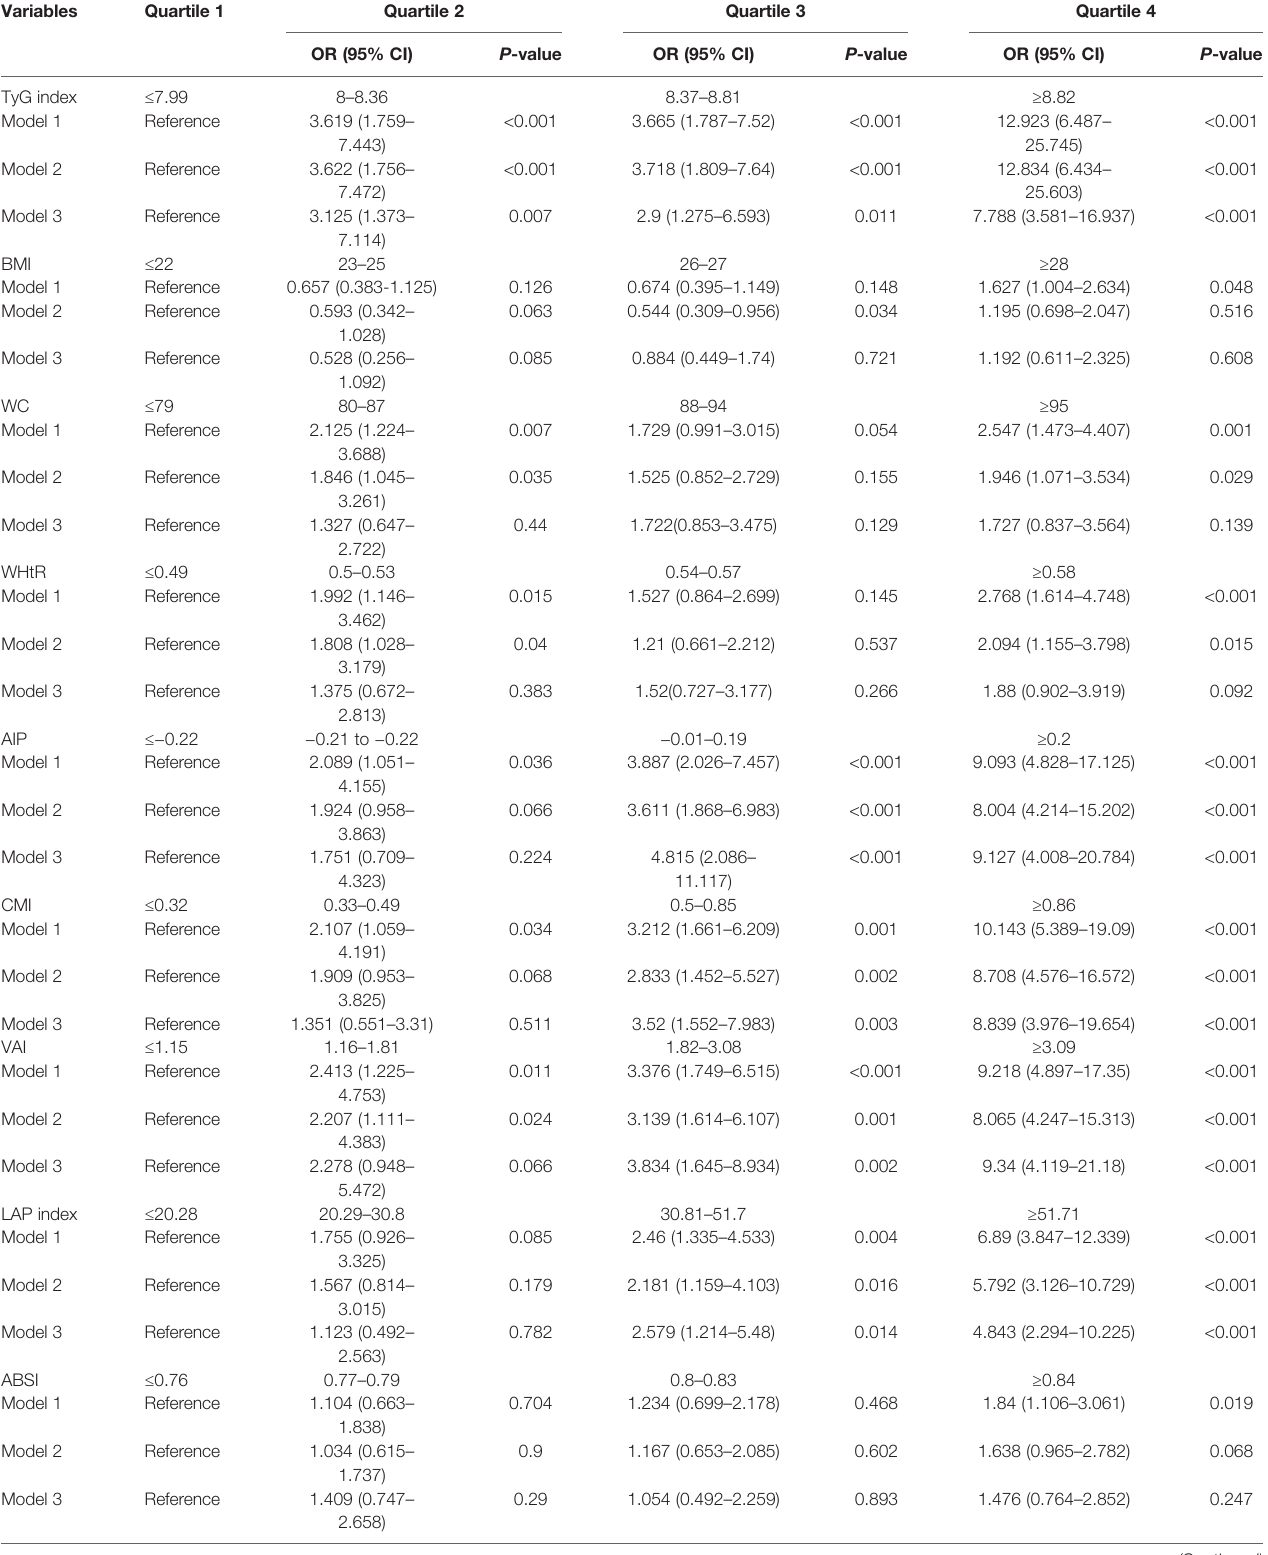
TABLE 4 | Multivariate logistic regression of different indices for HUA